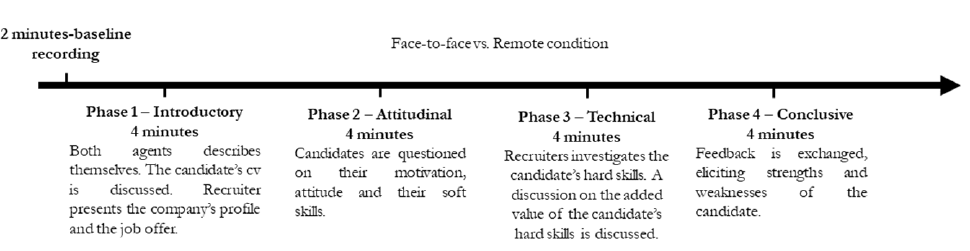
Figure 1. The four phases of the job interview. The four phases carried out during the experiment task by the dyads: introductory, attitudinal, technical, and conclusive.